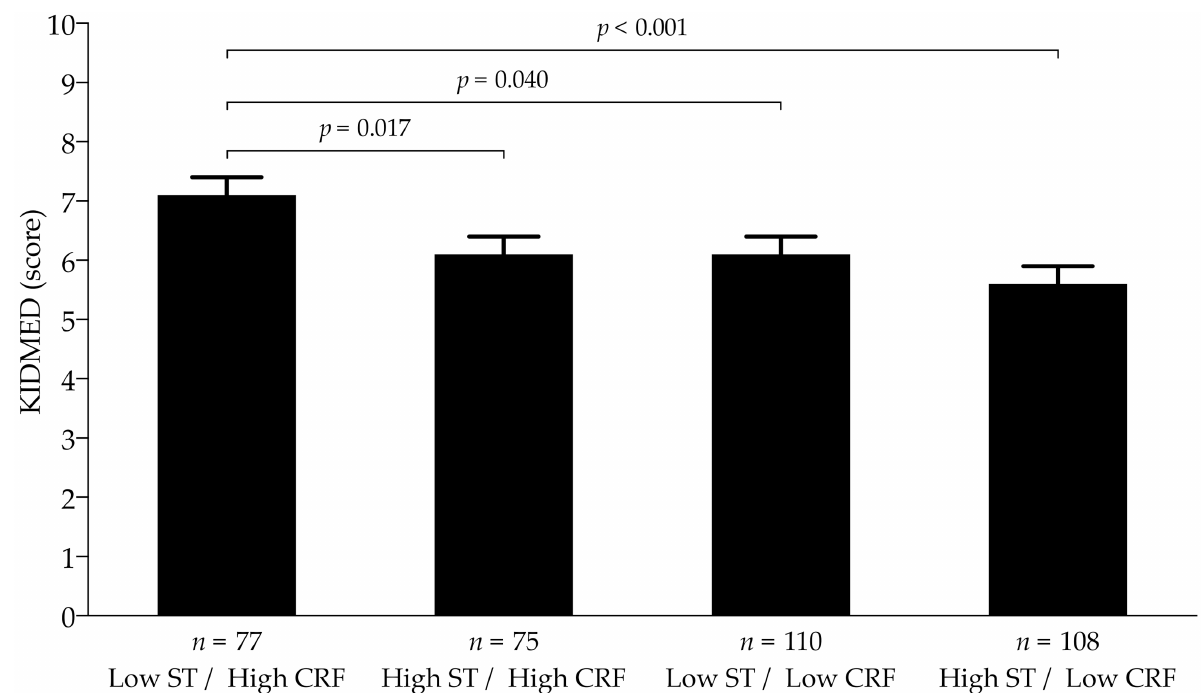
Figure 1. Combined effects of cardiorespiratory fitness and recreational screen time on adherence to the Mediterranean diet in schoolchildren. Estimated mean (dots) and 95% CIs (error bars) represent values after adjustment for age, sex, area of residence, type of schooling, and body fat percentage. CRF, cardiorespiratory fitness; ST, screen